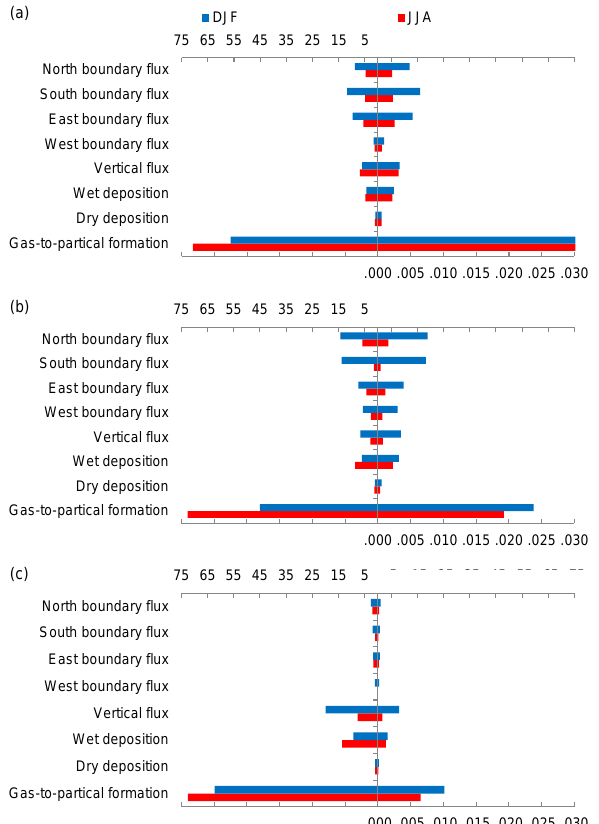
Figure 12. The MAD (TgNseason − 1 , right) and relative contri- bution (%, left) of each nitrate process (flux) in (a) NC, (b) SC, and (c) SCB obtained from simulation ANNmet. Blue lines are for DJF and red lines are for JJA. Transport fluxes were calculated at the boundaries while other sources and sinks were calculated as the sums over the grid cells of the region under 1km.